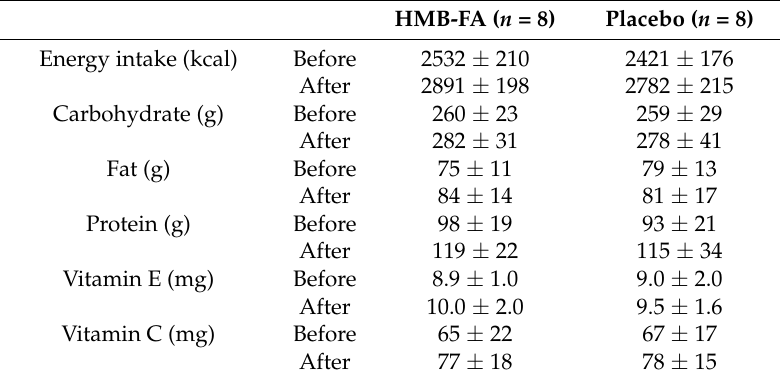
Table 2. Dietary intake assessed for the HMB-FA and placebo supplementation